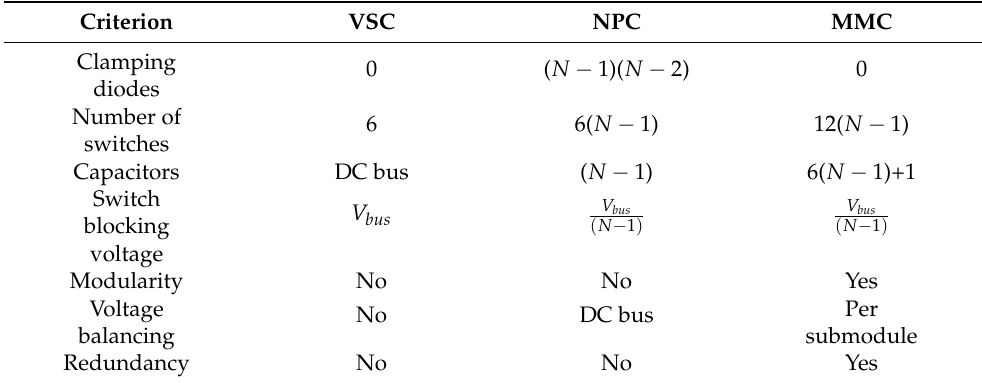
The synthesized voltage levels for the 3L-MMC are three pole voltage levels and nine phase voltage levels, such as in the 3L-NPC. According to the state of the MMC submodule switches, the capacitor is inserted or bypassed. Thus, the voltage of each submodule V SM that synthesizes the output voltage levels can be described by a switching function as